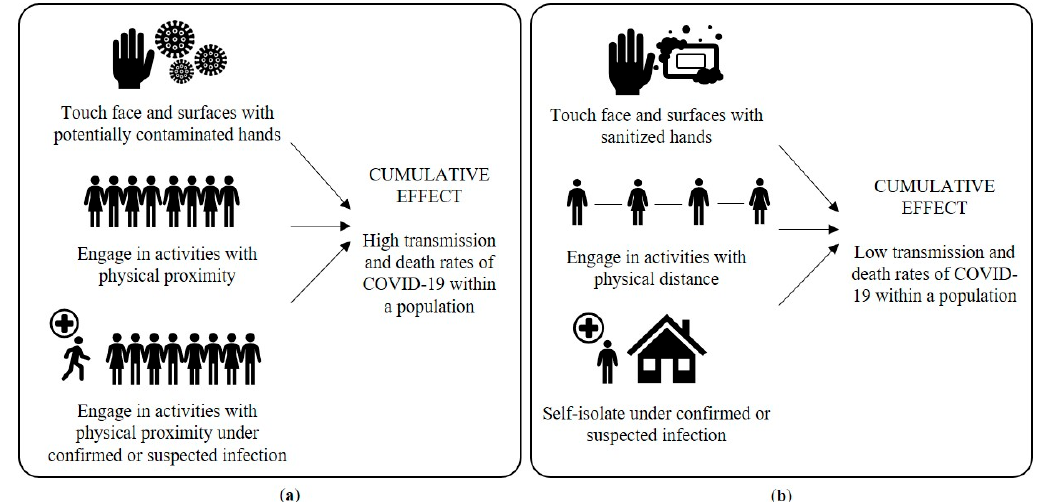
Figure 2. ( a ) Defective macrocontingency comprised of behaviors that increase the spread of COVID-19; ( b ) protective macrocontingency to contain the spread of COVID-19.